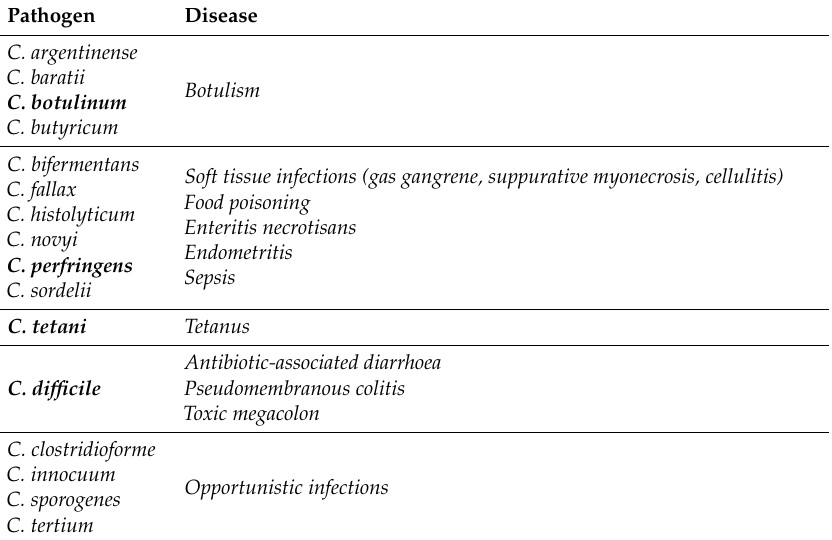
Table 3. Illnesses caused by human pathogenic species of the Clostridium genus [6,7,17,18,87–90].